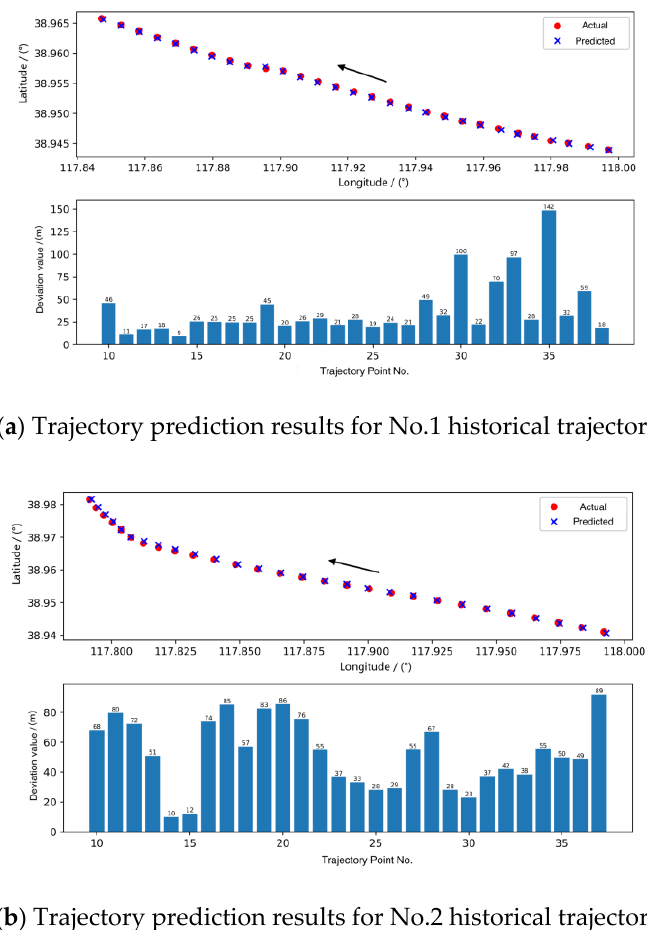
Figure 17. Real AIS trajectory prediction results.